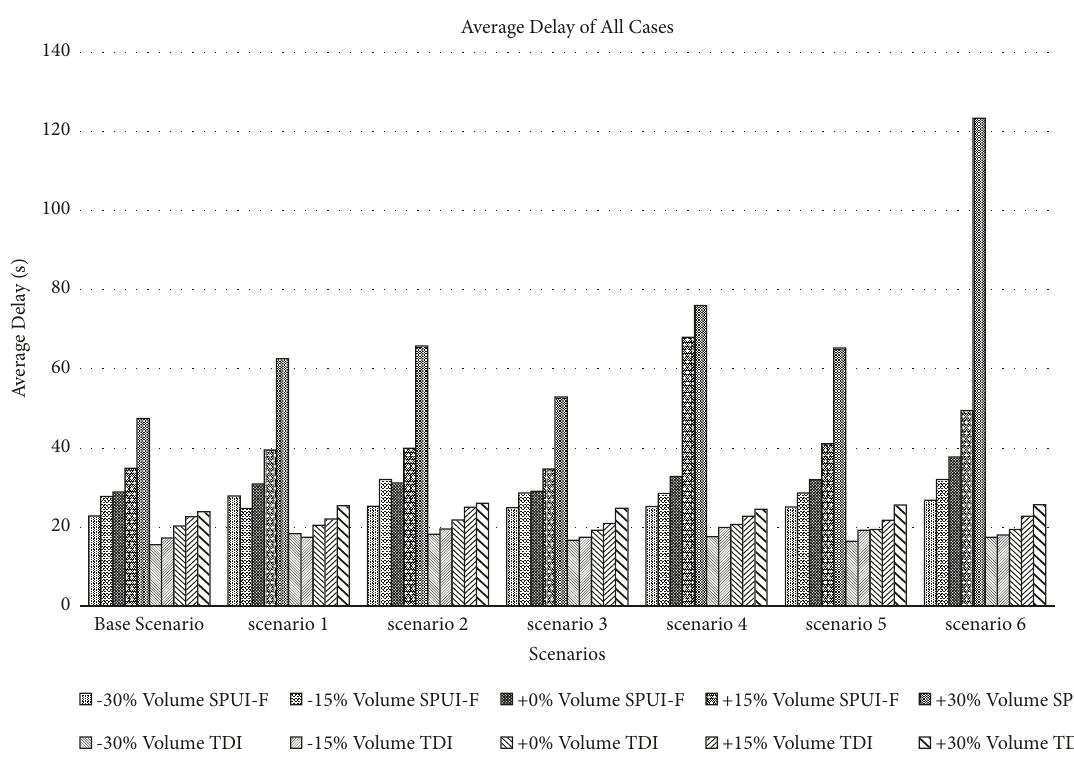
Figure 4: Comparison of average delay under various volume scenarios.